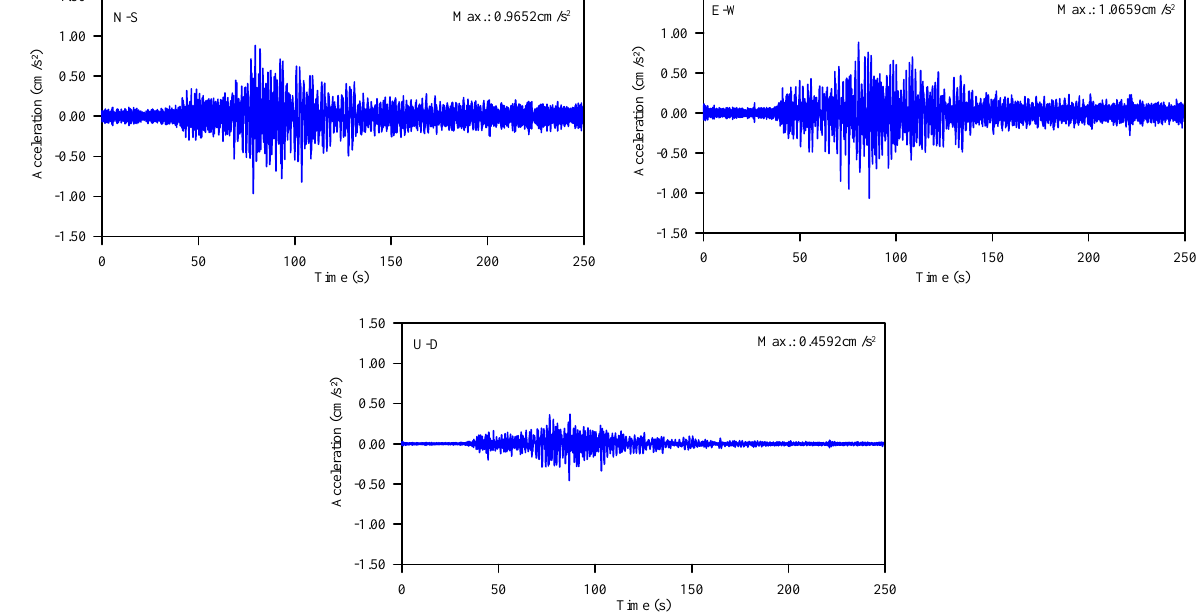
Fig. 4 Acceleration records of Bala (Ankara) Earthquake on December 20, 2007.